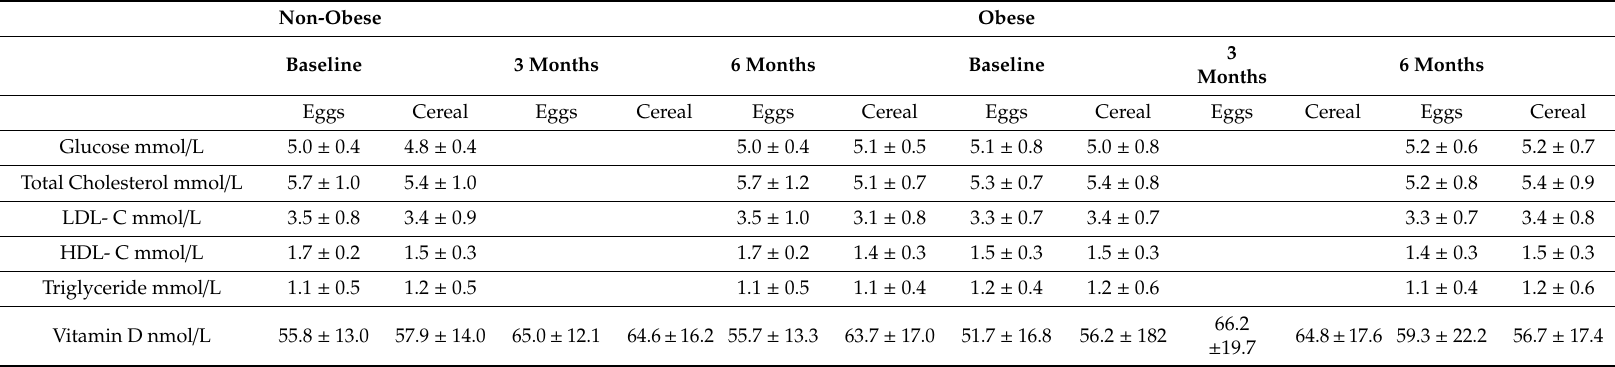
Table 5. Glucose, lipid and Vitamin D concentrations in non-obese ( n = 9 egg group, n = 11 cereal group) and obese ( n = 23 egg group, n = 30 cereal group) participants who completed the study at baseline, 3 months (Vitamin D only) and 6